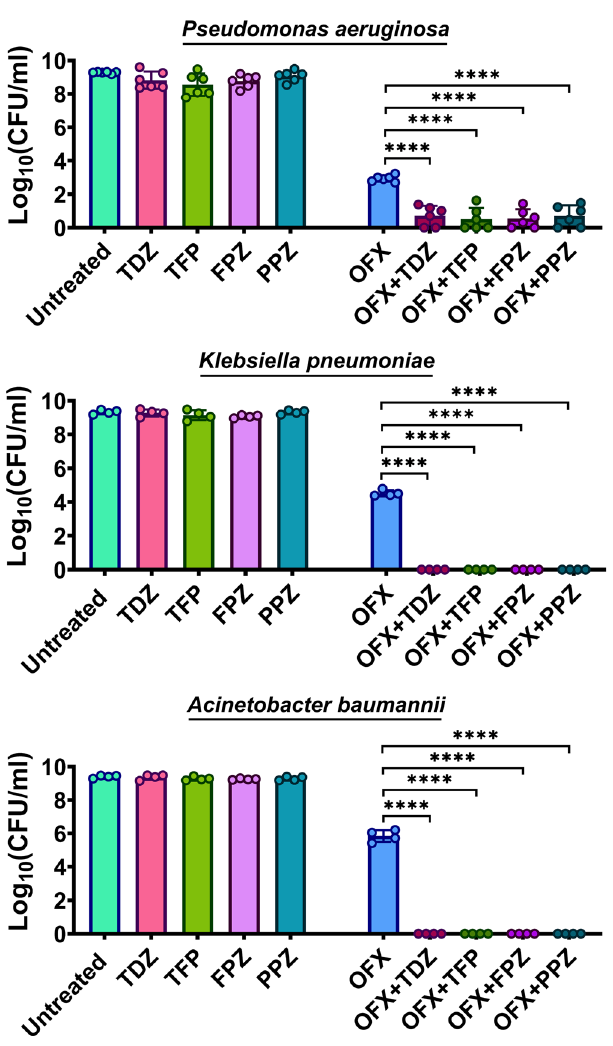
Fig. 3 Phenothiazine drugs reduced persister levels of Gram-negative bacteria. Early stationary phase cells of P. aeruginosa, K. pneumonia , and